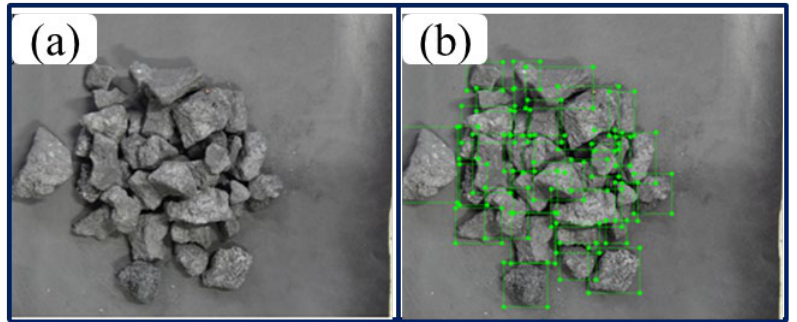
Figure 8. Example of the dataset for Faster R-CNN and YOLOv3 training. ( a ) Initial coke image; ( b ) Labeled coke image.